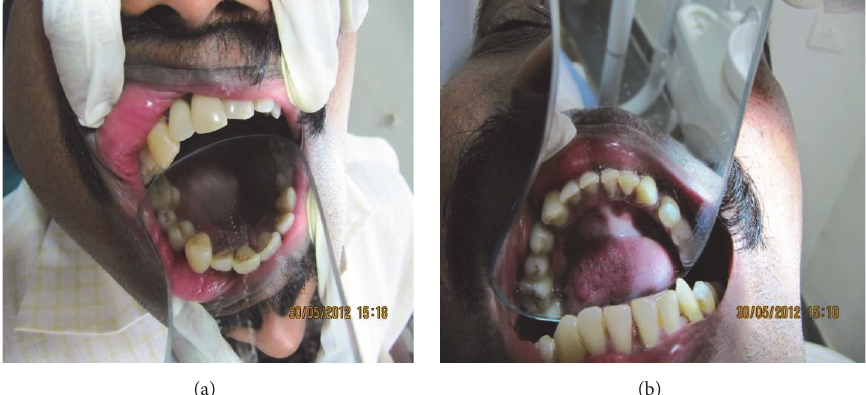
Figure 3: ((a) and (b)) Intraoral examination showing right sided enlargement of maxillary and mandibular arches with corresponding macrodontia.